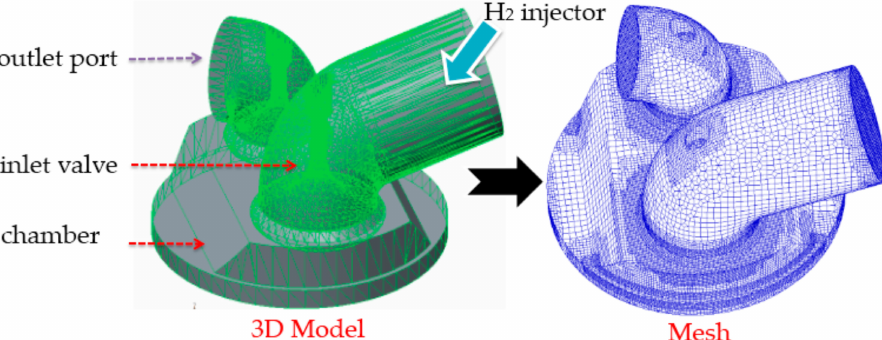
Figure 1. Computational fluid dynamics (CFD) model of a hydrogen